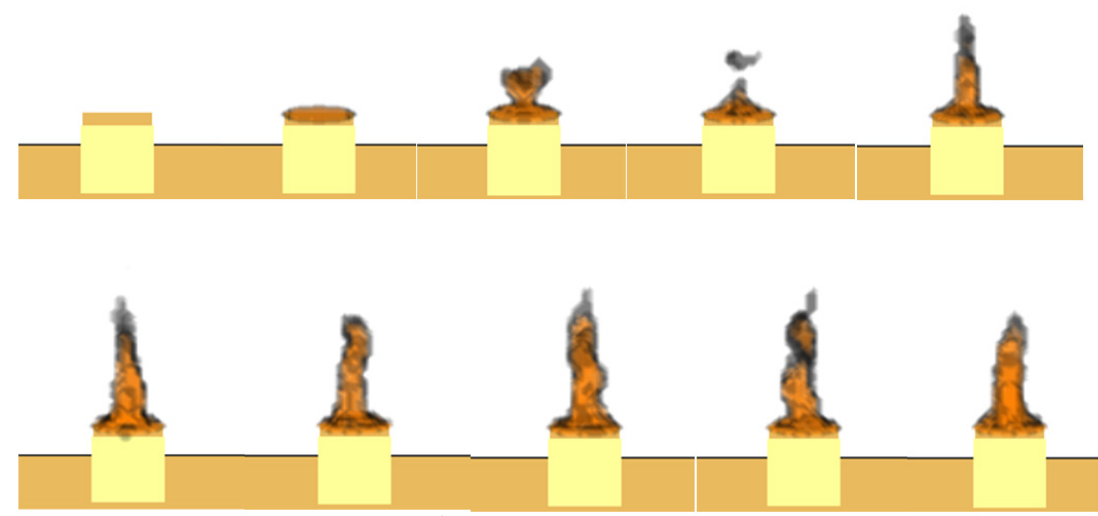
Figure 3. Stages of 31 cm methanol pool fire till it attains a steady state.